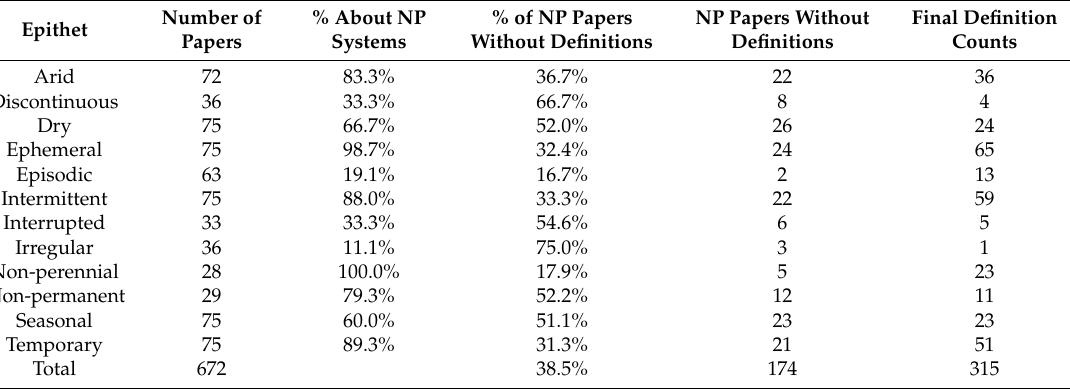
Table 2. Content of papers by epithet (NP refers to non-perennial). We examined 672 papers to mine definitions. However, many of these papers were not about non-perennial systems or lacked definitions. “Non-perennial” had the lowest number of papers included in the analysis, the largest percentage of papers that were about non-perennial systems, and one of the smallest proportions of papers without definitions (only “episodic” was